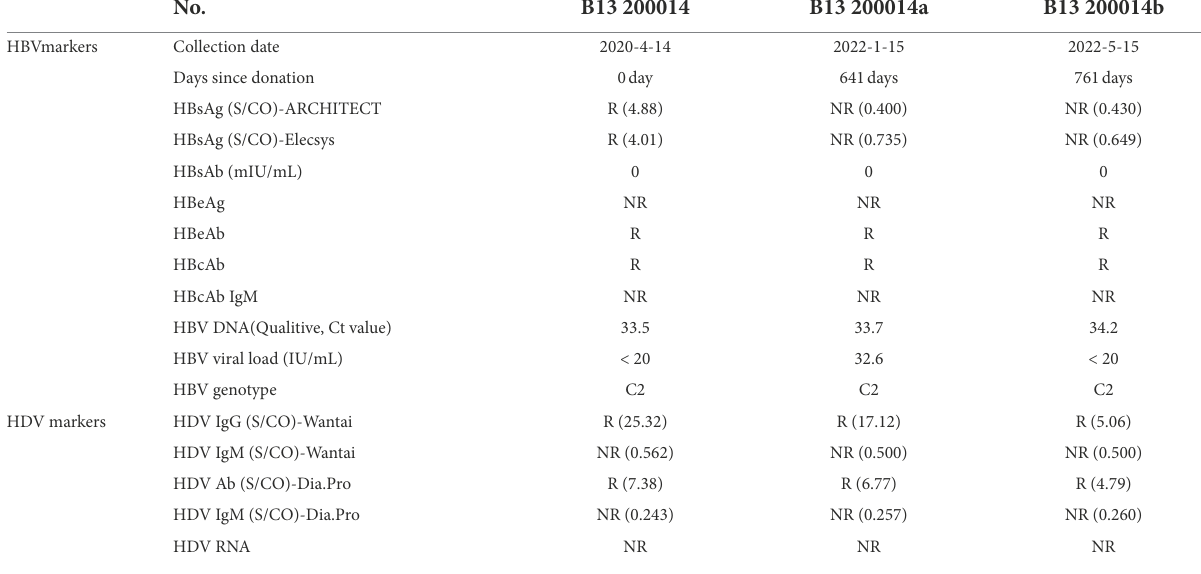
TABLE 3 Follow-up results of an anti-HDV-positive donor.